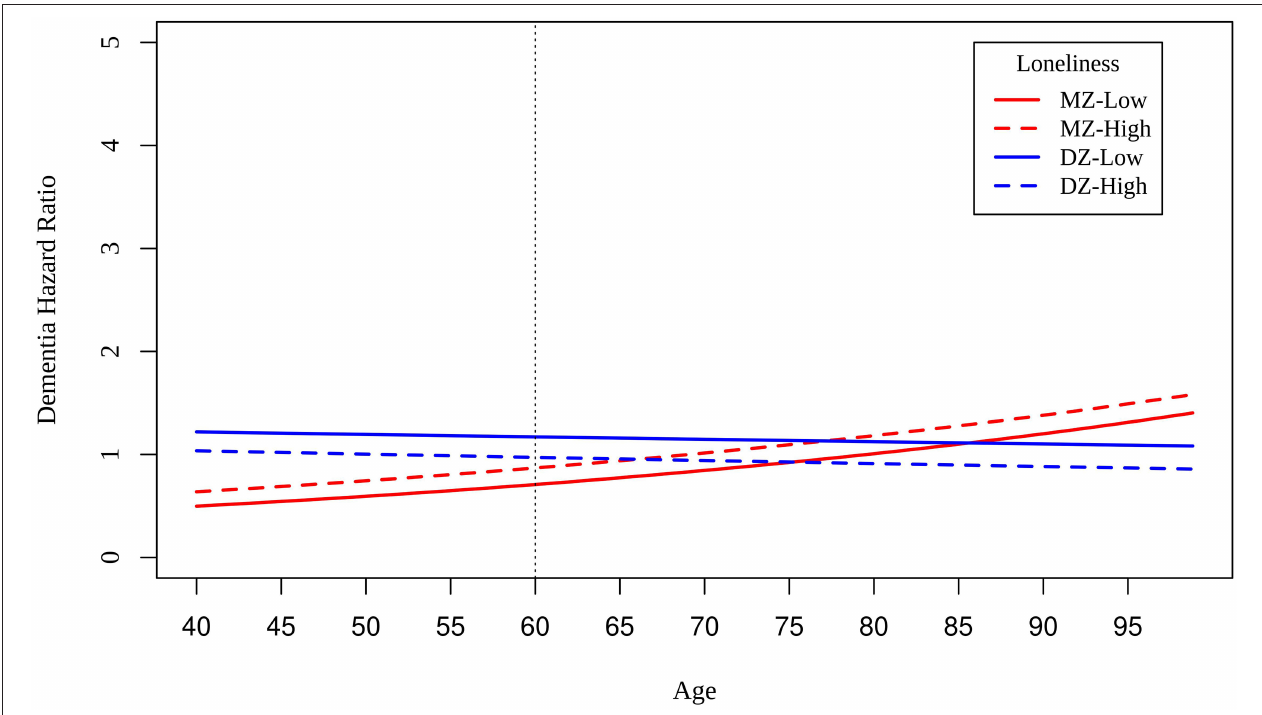
FIGURE 3 | Hazard ratios of dementia for MZ twins (red lines) and DZ twins (blue lines) who are low (solid lines) and high (dashed lines) on loneliness scores at baseline.